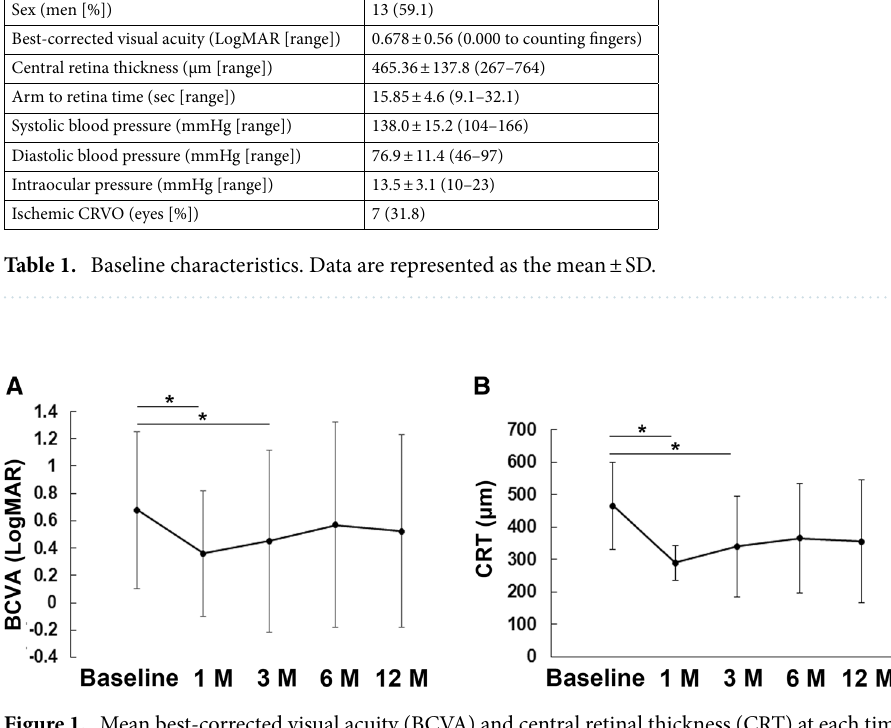
Figure 1. Mean best-corrected visual acuity (BCVA) and central retinal thickness (CRT) at each time-point after initial anti-vascular endothelial growth factor treatment. Data are represented as the mean ± standard deviation. The values at 1 and 3 months post-treatment were improved compared with those at baseline; however, this improvement was not observed at the 6 and 12 month time-points. Generalized mixed model analysis, *P <